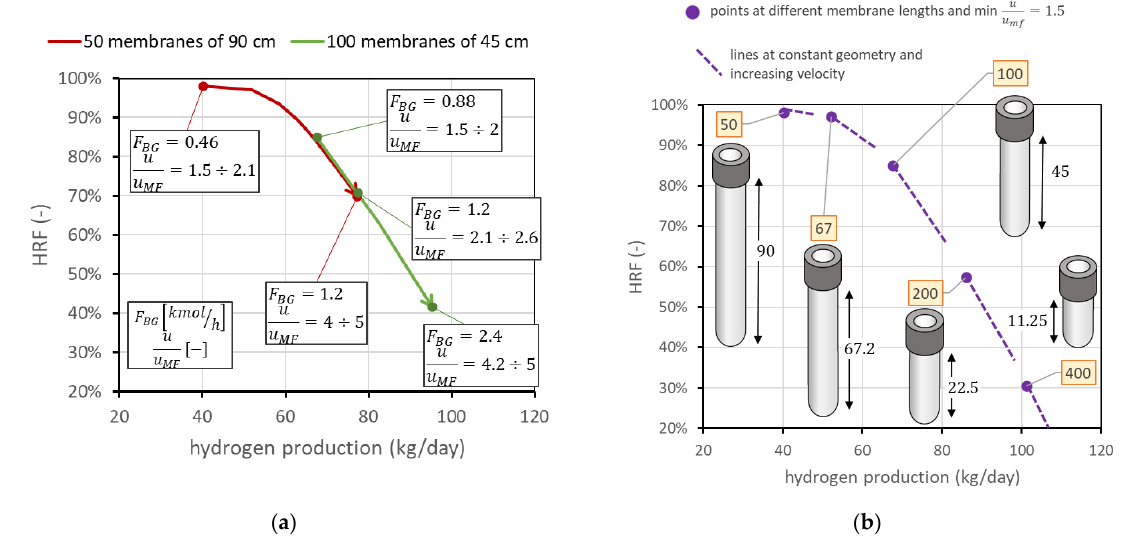
Figure 12. ( a ) Comparison of performance with same total membrane area using 100 membranes of 45 cm length (nominal values) against 50 membranes of 90 cm length. ( b ) Positions of the point with minimum 𝑢/𝑢 𝑚𝑓 = 1.5 for different membrane lengths and numbers, always considering the same total membrane area. Labels indicate the number of membranes.